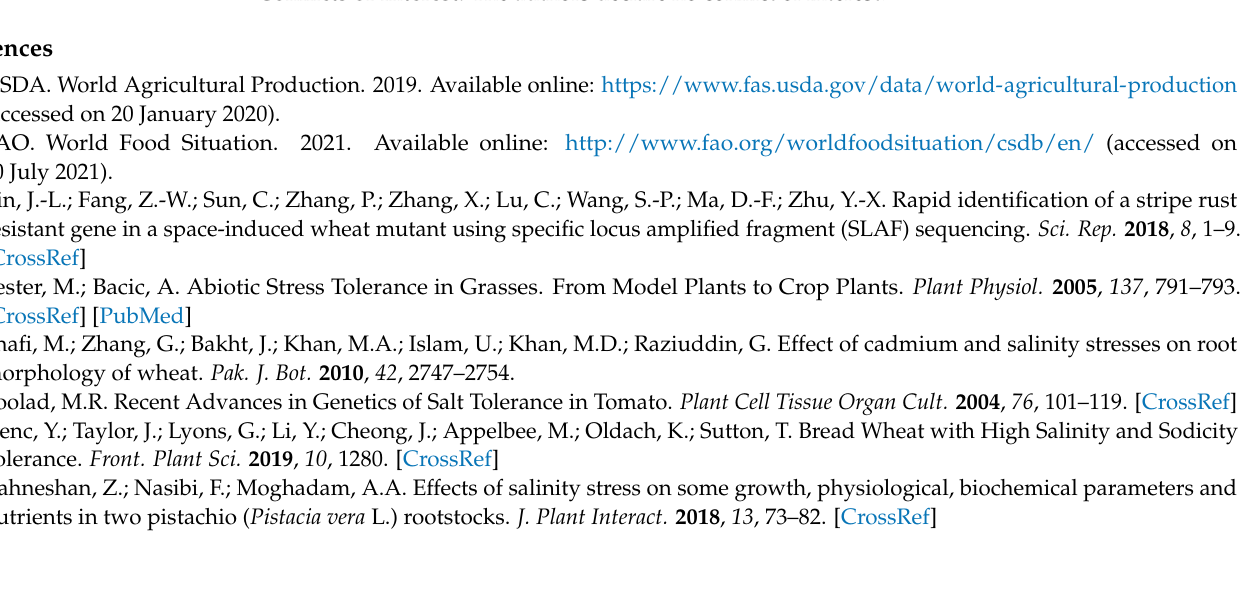
10.3390/genes12111652/s1 Figure S1. Schematic illustration of 3-D protein structures and the Ra- machandran plot for TaTPP proteins, Figure S2. Schematic representation of protein alignment of all TaTPPs, Figure S3. Schematic representation of TaTPP1-A side chains catalytic triads, Figure S4. Heat map of TaTPPs transcriptions in wheat development stages, Figure S5. Protein–protein inter- action analysis of TaTPP proteins, Figure S6. Radiation tree of TaTPPs along with TPPs from other species, Table S1. List of primers used for TaTPPs qRT-PCR analysis, Table S2. TPP protein sequences identified from wheat genome, Table S3. Number of TPP proteins in different plant species, Table S4. Sequence identity and query cover of TaTPP proteins, Table S5. Pairwise identities and divergence between TaTPP genes and details about the duplication of those genes, Table S6. Phylogenetic tree member with their gene ID, Table S7. The synteny relationships of wheat TPP genes with different plant species, Table S8. Details of the calculated secondary structure elements TaTPPs by SOPMA, Table S9. Validation of TaTPP protein structures, Table S10. Frequency of all identified Cis -Regulatory Elements (CREs) in different TaTPPs promoters, Table S11. Cis -Regulatory Elements (CREs) with sequences and functions, Table S12: The protein-protein interaction network between TaTPPs and other proteins in